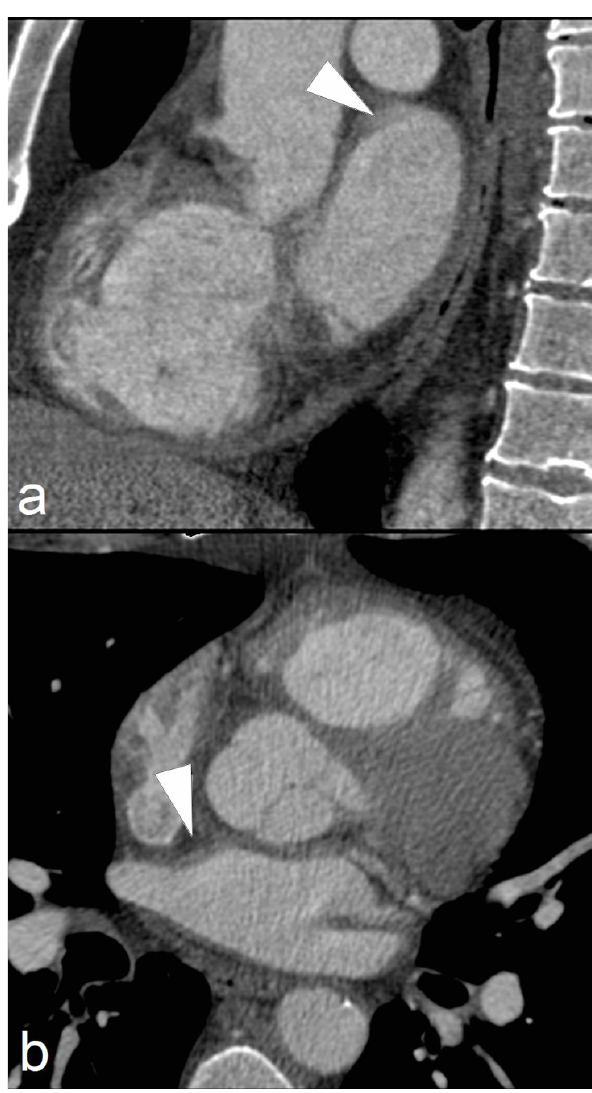
Fig. 5. Helical non-gated MDCT in a) the sagittal and b) the axial plane; the images show blurred surface of the left atrium (arrowheads) as a result of motion; the visual image quality was graded as